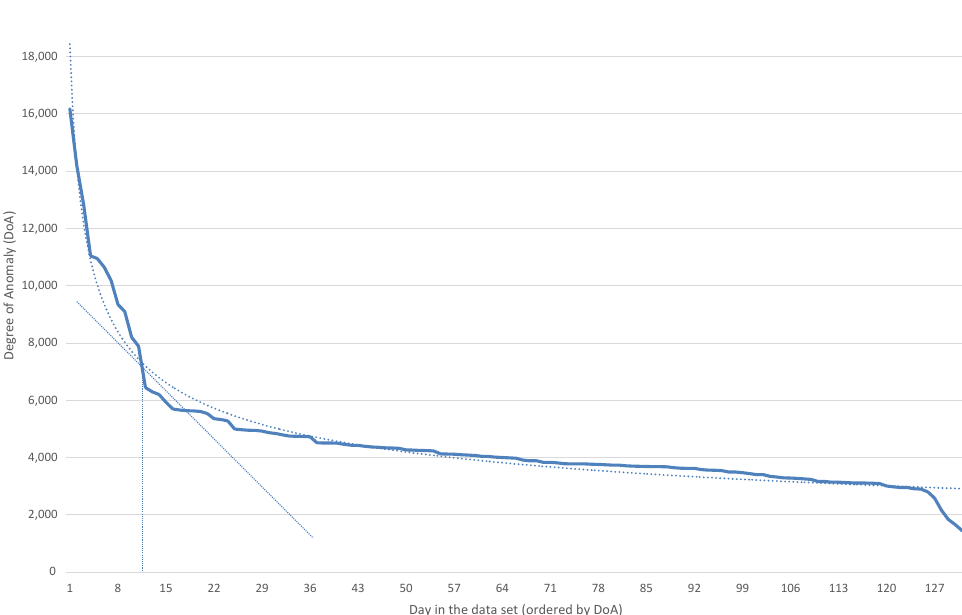
Figure 3. Days in the data set ordered according to entropy.